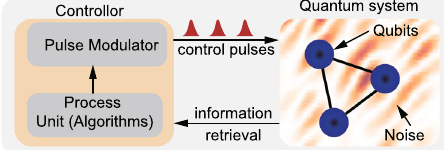
Fig. 1 Schematic diagram of quantum sensing. Hamiltonian can be time-dependent or time-independent. Unknown Parameters can be single and multiple. The background noise will cause the the qubit relaxation and dephasing.